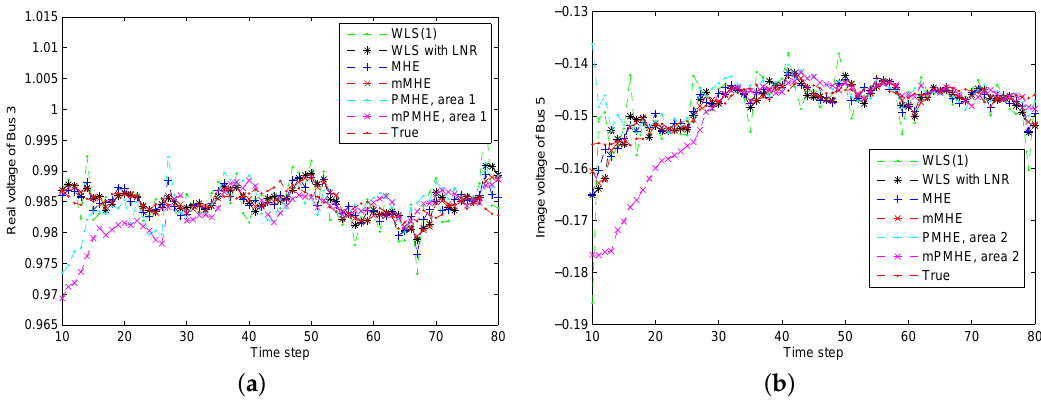
Figure 7. The estimated results of different estimators under non-Gaussian noise assumption. “WLS(1)” represents the results when the WLS estimator uses the measurements with horizon length 1. ( a ) the real part of Bus 3 voltage phasor. ( b ) the imaginary part of Bus 5 voltage